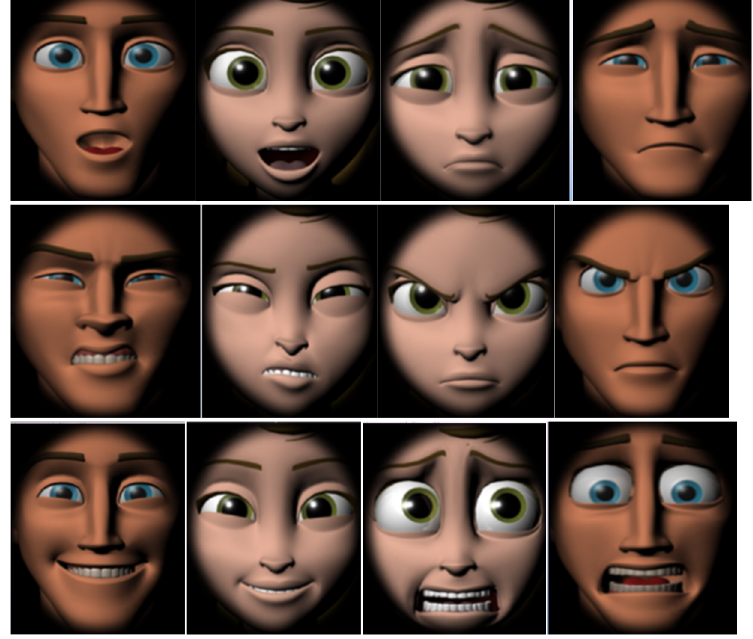
Figure 2. Frames of cartoon faces without distracting elements.